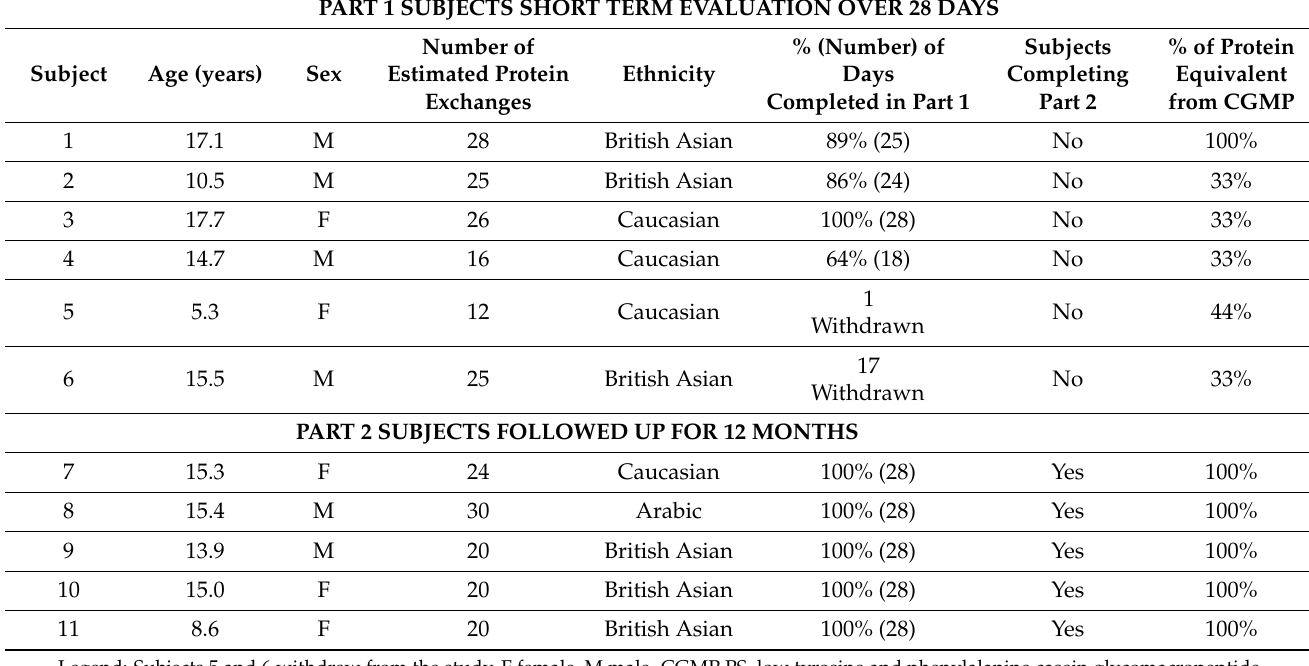
Table 2. Subject characteristics and numbers recruited to study parts 1 and